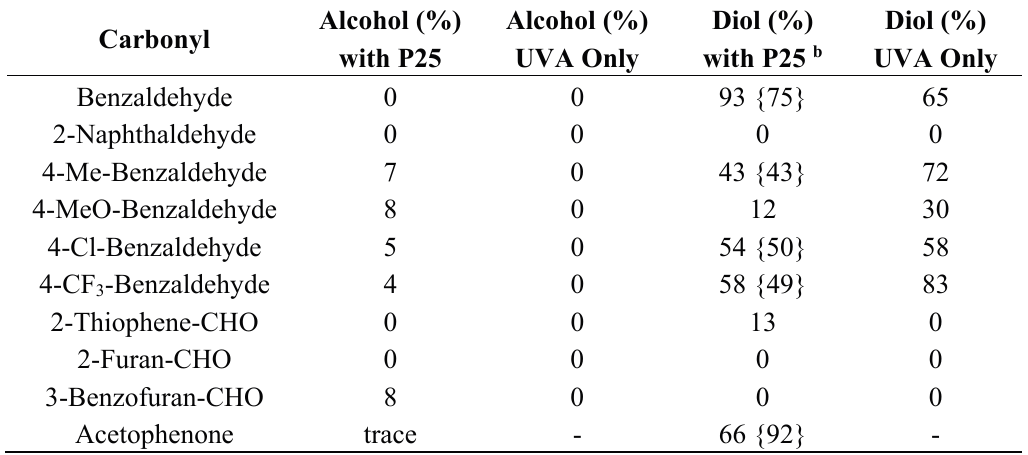
Table 3. Comparison of carbonyl photolyses with and without P25 SCPC a .